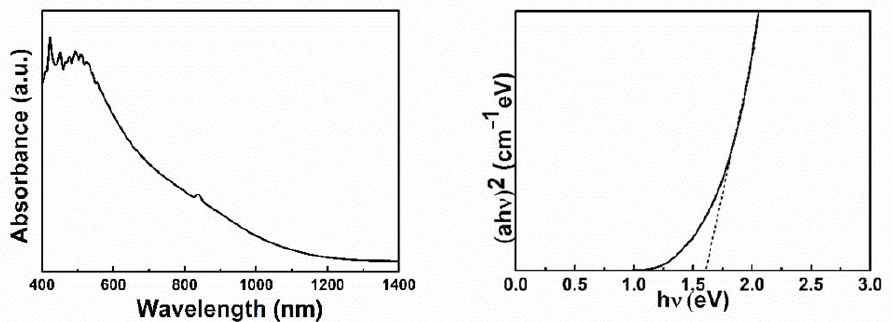
Figure 2. UV-vis-NIR absorption spectra of the as-coated CZTS thin film and corresponding (αhν) 2 vs. hν curve.